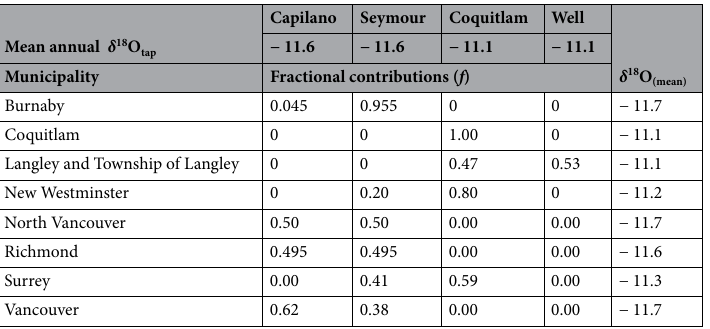
Table 4. Fractional contributions of water sources to MV municipal tap water